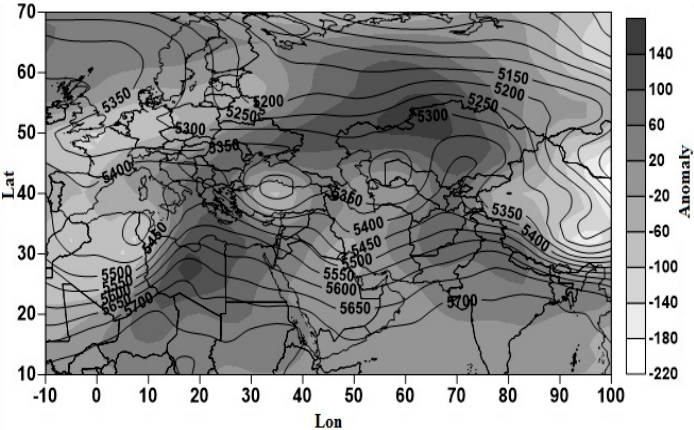
Figure 7. Anomalies and atmosphere thickness (in meters) for the representative day of the third pattern.